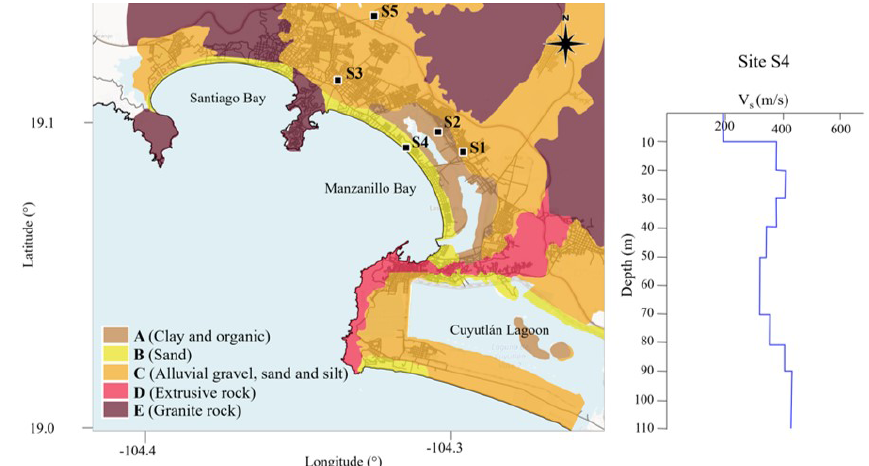
Figure 6. Survey sites S1–S5. Geotechnical characterization of Manzanillo and Santiago bays obtained from Tonatiuh Dominguez et al. (2017) and shear wave velocity at site S4.